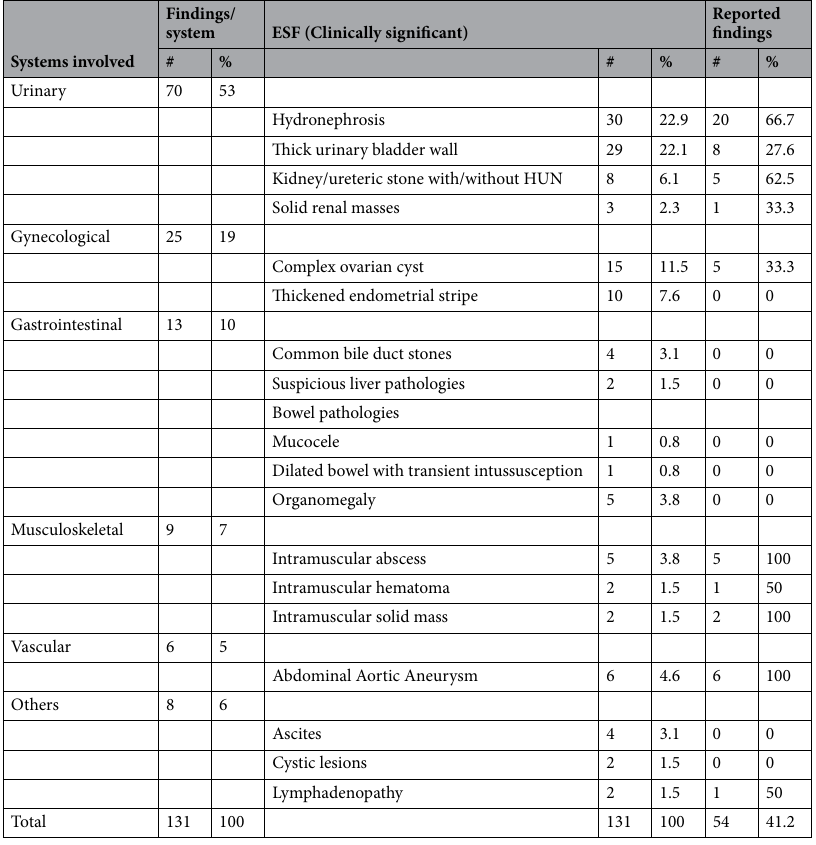
Table 2. The distribution of the clinically significant extraspinal findings and their reporting rates. ESF extraspinal findings, #: number, %: percentage, HUN